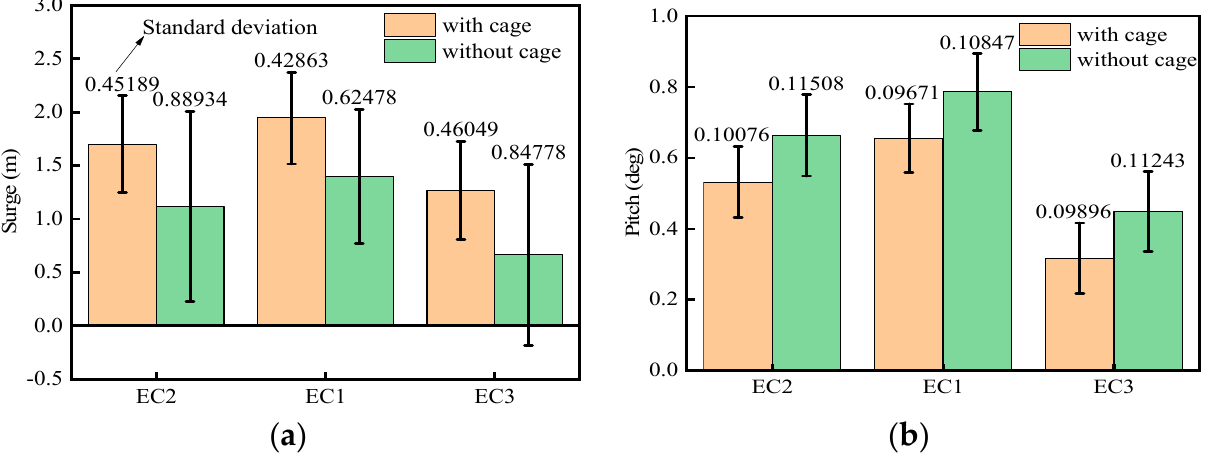
Figure 15. Comparison of motions for the barge-type FOWT-AC and barge-type FOWT at different wind speeds: ( a ) Mean and standard deviation of surge; ( b ) Mean and standard deviation of pitch.